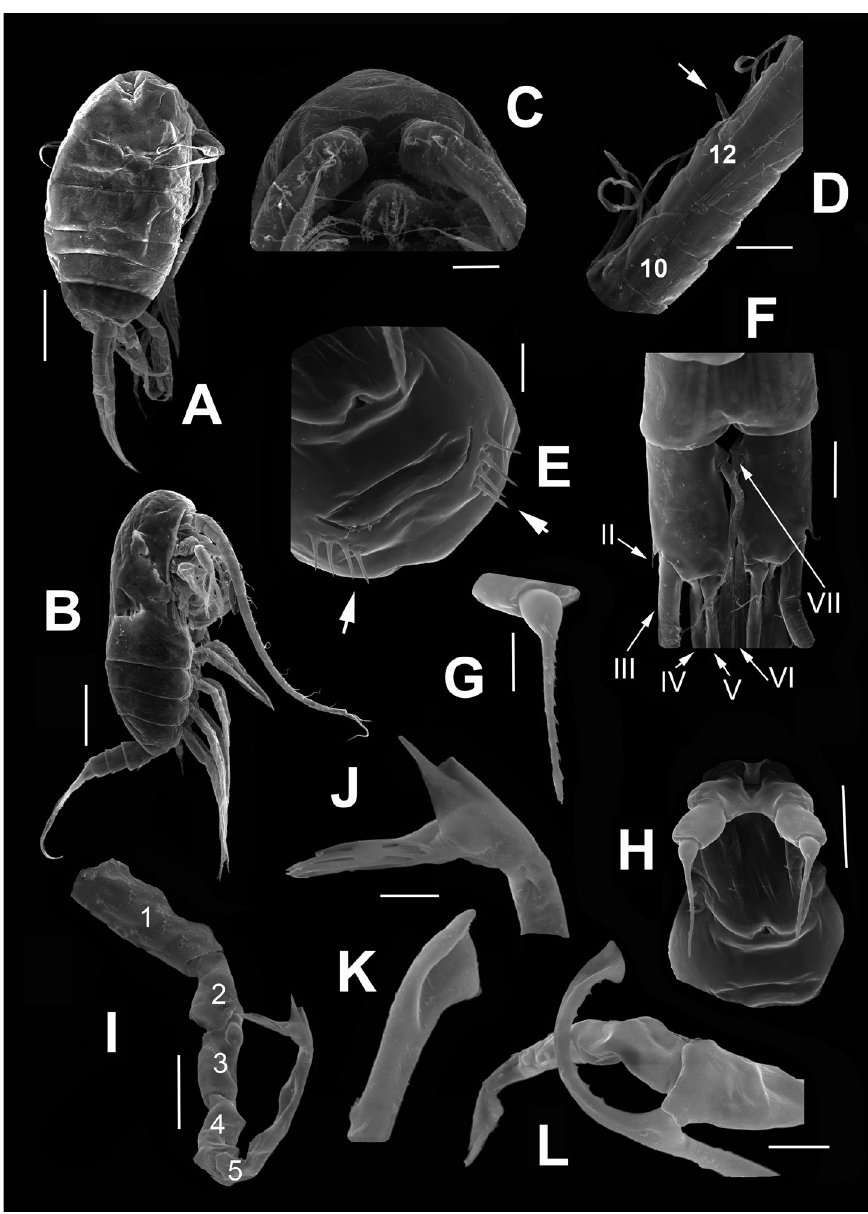
Figure 4. Stephos fernandoi sp. n., from Cozumel, Mexico. SEM-processed specimens. Female. A habi- tus, semi-lateral view B same, lateral view, another specimen C rostrum, ventral view D antennule seg- ments 9–13, spiniform seta on segment 12 arrowed E genital double-somite, ventral surface showing ornamentation (arrows) F caudal rami showing caudal setae II-VII, ventral view G distal segment of leg 5 H leg 5, ventral view. Male. I left leg 5 showing segmentation J same, detail of distal segment K right leg 5, distal segment, detail of apical end L right leg 5, distal segment. Scale bars A, B 100 µm; C, D, H, I 20 µm, E–G, L 10 µm; J, K 5